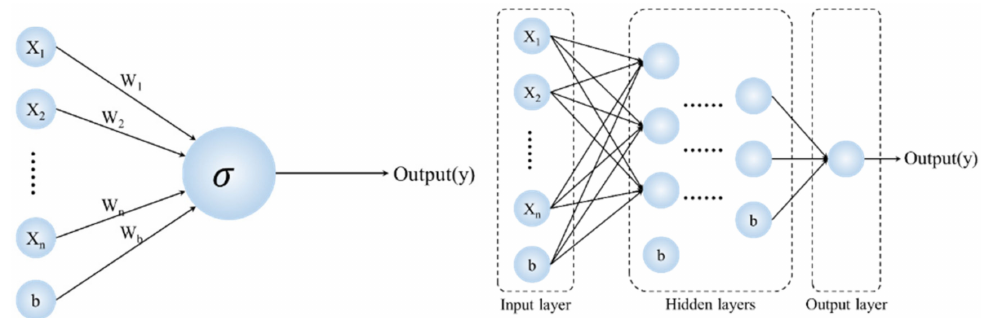
Figure 4. Schematic diagram of neurons ( left ) and multilayer perceptron (MLP) ( right ). Multi layer perceptron (MLP) can be obtained by combining multiple neurons,